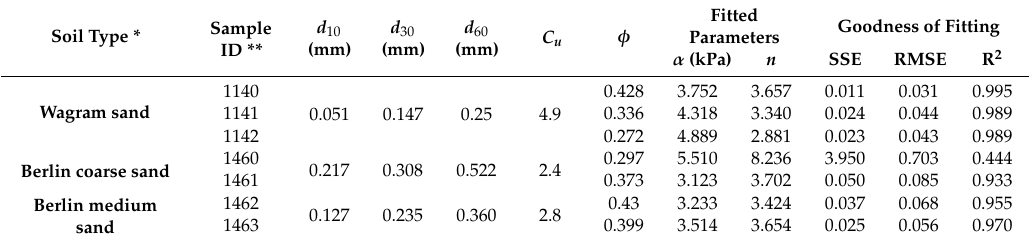
Table 2. Soil gradation parameters, porosity values and best fitted WRC parameters ( α and n ) for the three sandy soils which are employed for the model